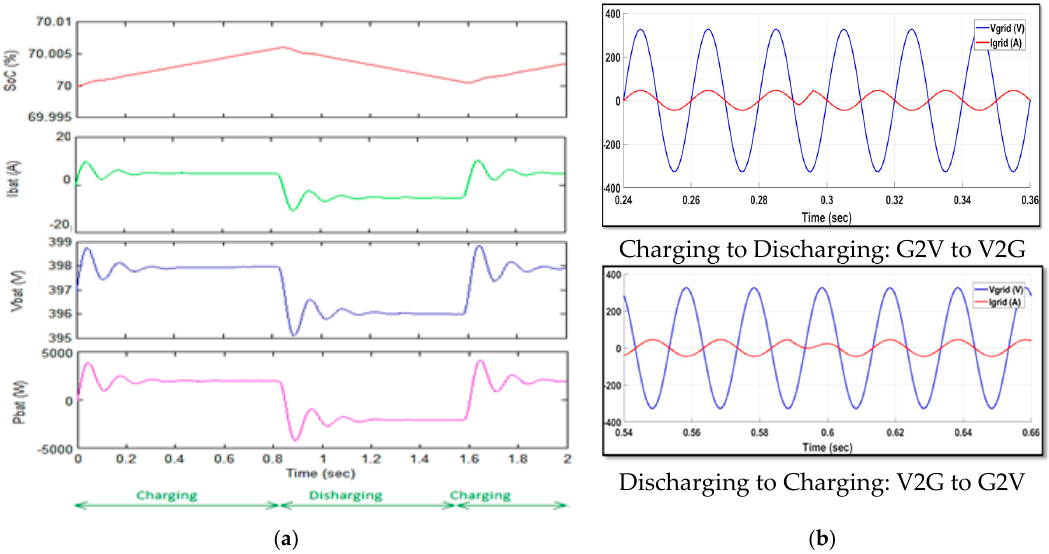
Figure 22. Transitions in the operation mode for Light-Duty Vehicles. ( a ) Battery Curves; ( b ) Grid Current and Voltage.